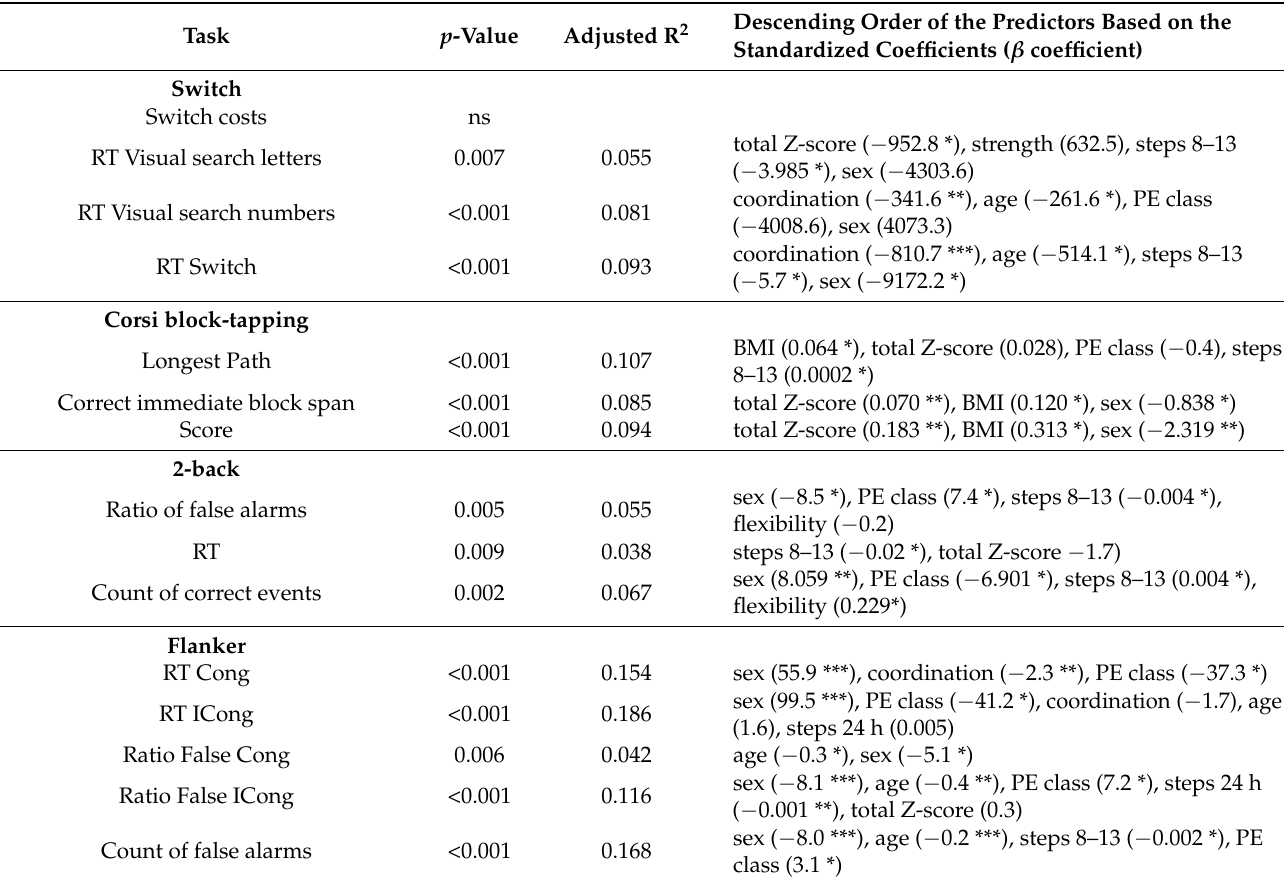
Table 4. Multivariable analysis of the associations between the fitness skills and the cognitive outcomes considering other predictors estimated by backwards